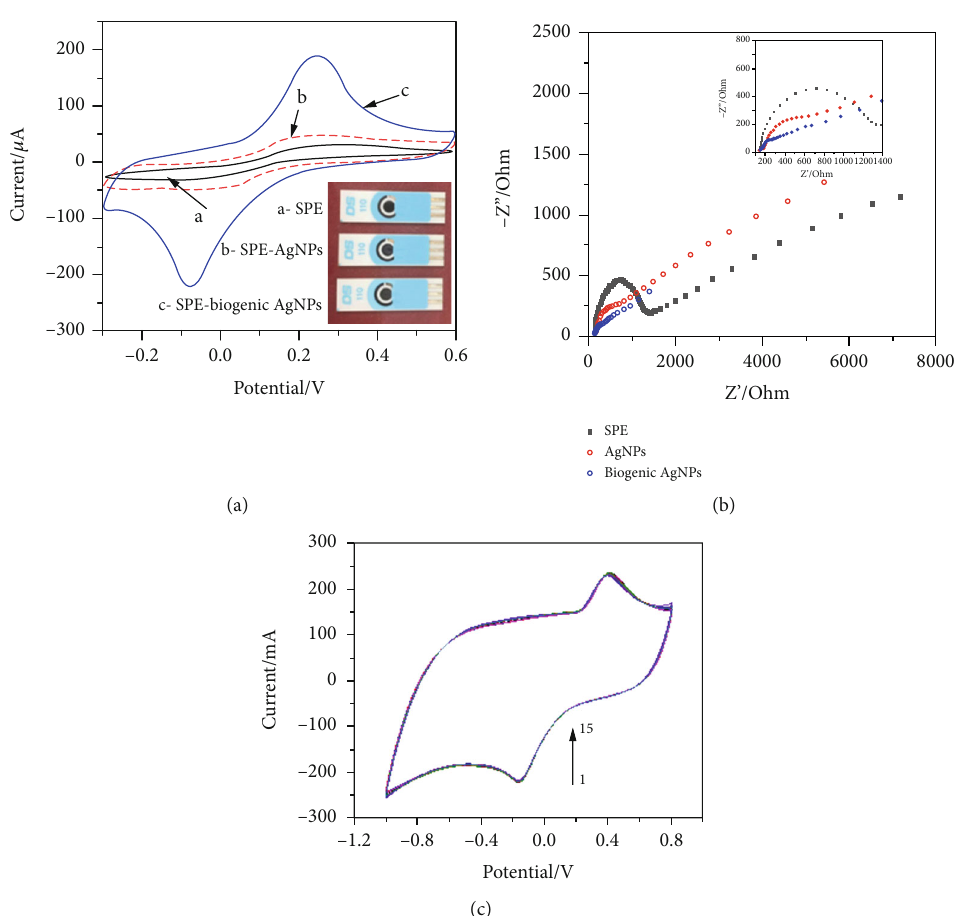
Figure 4: (a) CV of bare SPE (curve a), pure AgNPs-SPE (curve b), and biogenic AgNP-SPE (curve c) electrodes in 5 mM K [Fe(CN) ]/K [Fe(CN) ] (1 :1) mixture at 50mVs -1 ; (b) Nyquist plots of bare SPE, pure AgNPs-SPE, and biogenic AgNP-SPE electrodes 3 6 4 6 recorded in 0.1mol L -1 KCl solution containing 5mM K